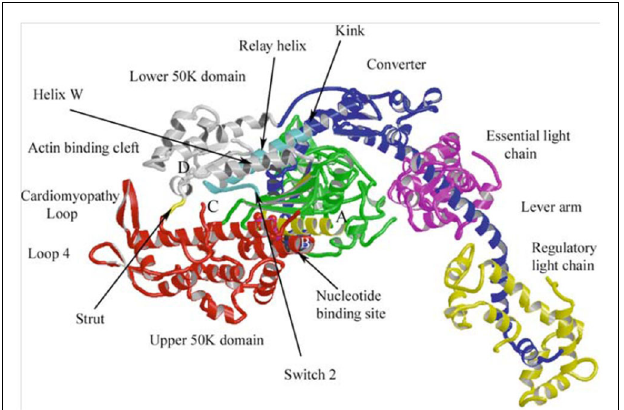
FIGURE 3 |Atomic structure of a myosin moleculeA ribbon representation of the head portion myosin (S1). The heavy chain is colored in blue, gray, green, and red, denoting different regions of the protein.The light chains are colored in yellow (Essential) and pink (Regulatory).The upper portion of the motor domain is separated by a large cleft (actin-binding cleft), the opening and closing of which modulates actin affinity. Subtle changes in the nucleotide-binding site are amplified in the converter region resulting in a large rotation of the lever arm. Figure from Geeves and Holmes (2005), reprinted with permission from the